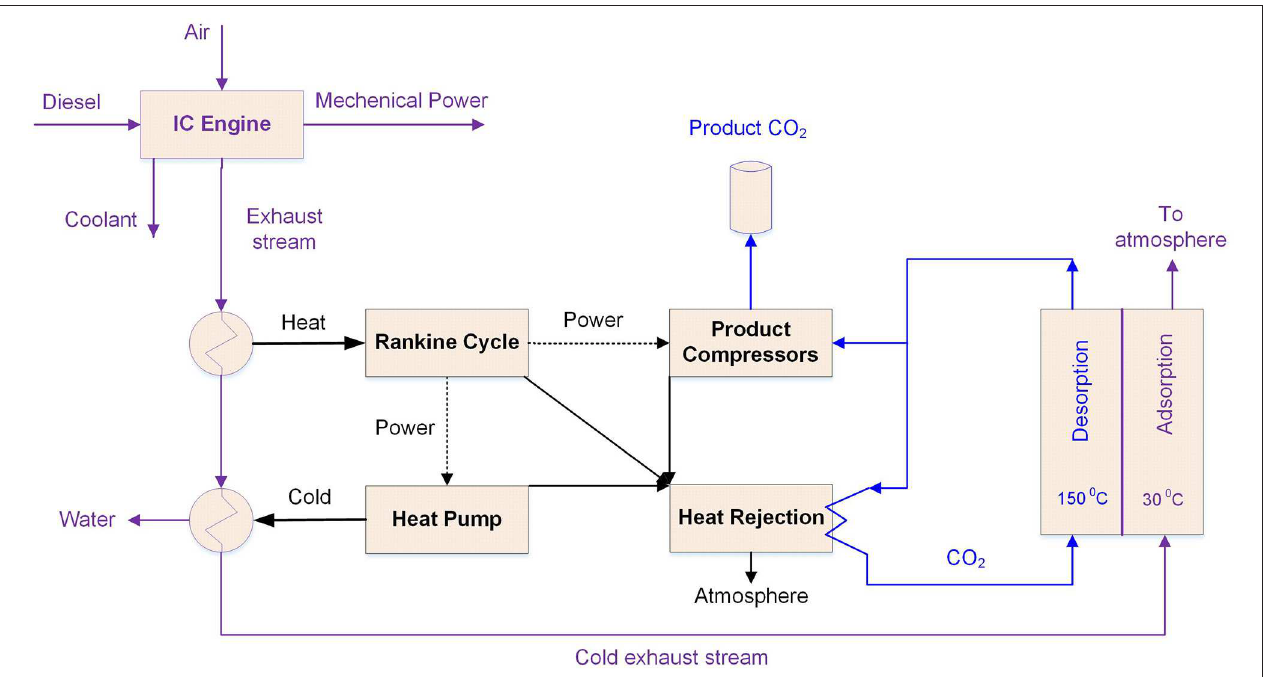
FIGURE 6 | Overview of CO 2 capture system design: integration of Rankine cycle (RC) and heat pump